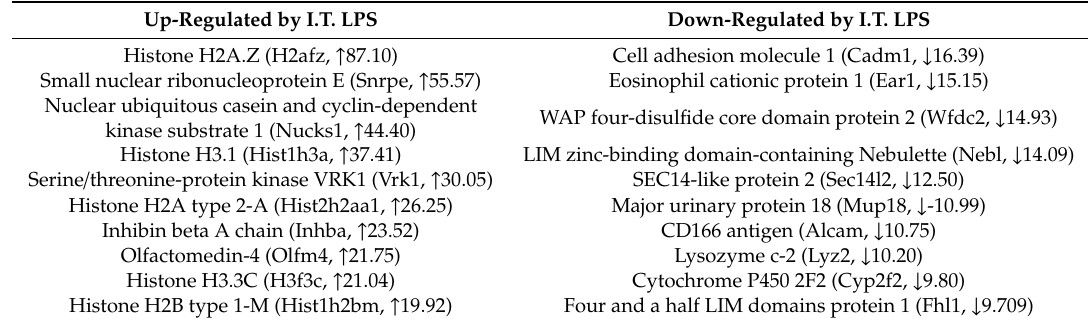
Table 3. Top 10 up- or down-regulated BALF proteins by I.T. LPS compared to the controls. Up-Regulated by I.T. LPS Down-Regulated by I.T. LPS Histone H2A.Z (H2afz, ↑ 87.10) Cell adhesion molecule 1 (Cadm1, ↓ 16.39) Eosinophil cationic protein 1 (Ear1, ↓ 15.15)